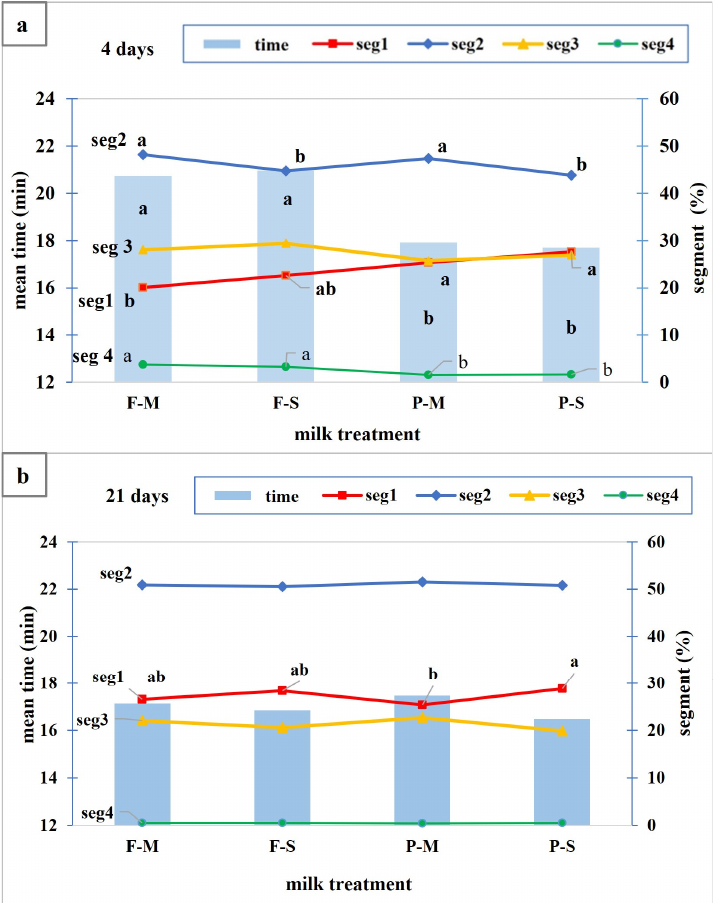
Figure 4. Mean retention time and segments of peptide pro fi le in digested cheese considering the data of 4-day-aged cheese ( a ) separately from data of 21-day-aged cheese ( b ). F-M: fresh minimally pasteurized milk; F-S: fresh strongly pasteurized milk; P-M: pre-treated minimally pasteurized milk; P-S: pre-treated strongly pasteurized milk. For each parameter, di ff erent le tt ers in the graph indicate signi fi cant di ff erences ( p < 0.05).